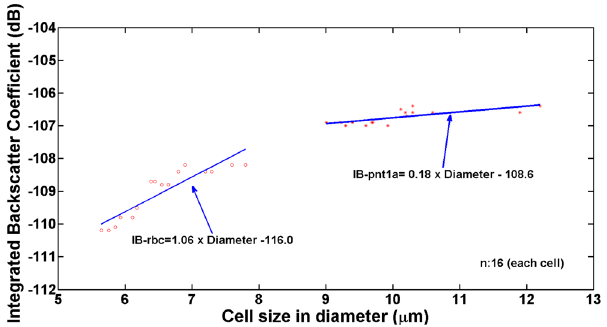
Figure 5. Measured integrated backscattering coefficients of trapped RBCs and PNT1A cells. The number of each sample was 16. The blue solid line indicates the slope of the IB coefficient obtained by linear regression analysis.